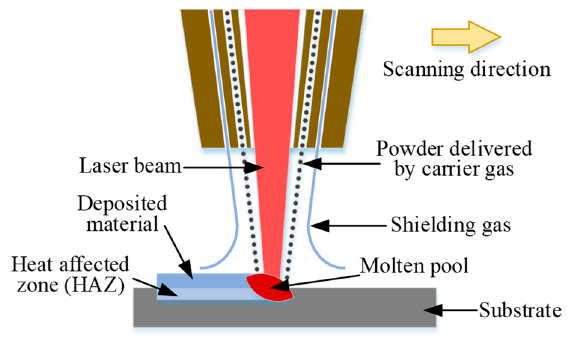
Figure 1. Schematic diagram of laser cladding process.